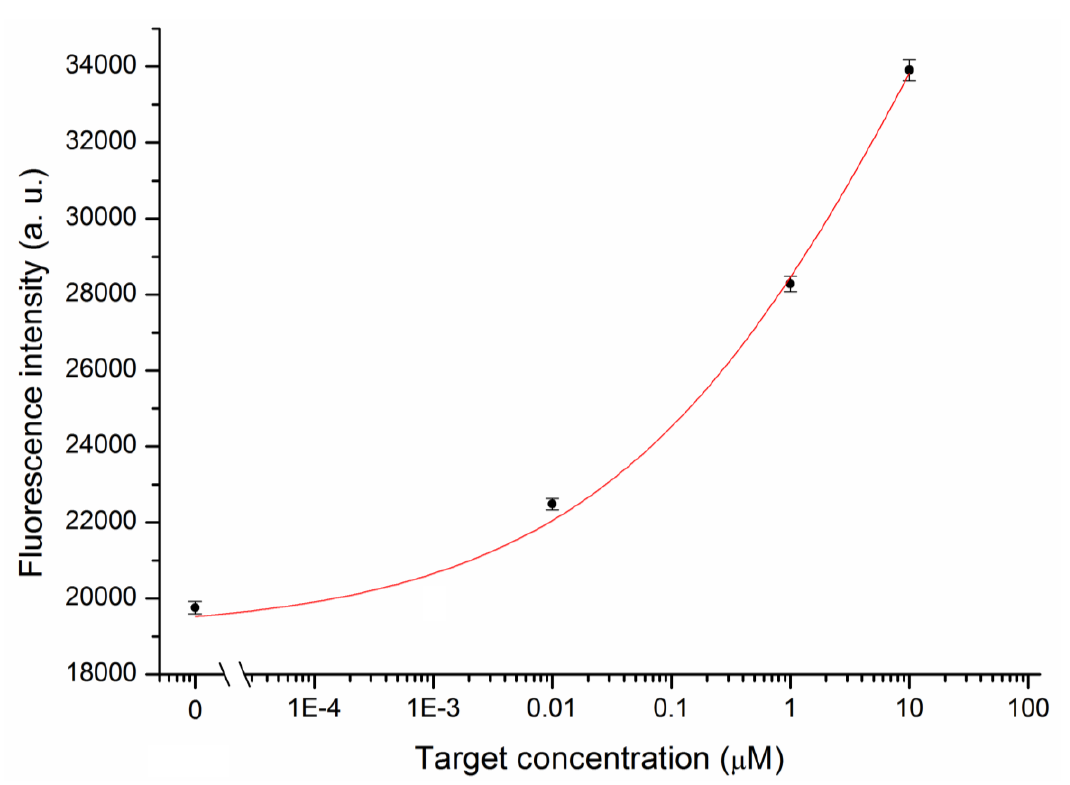
Figure 8. Calibration curve obtained from the interaction of the MB-coated nanotip with increasing concentrations of